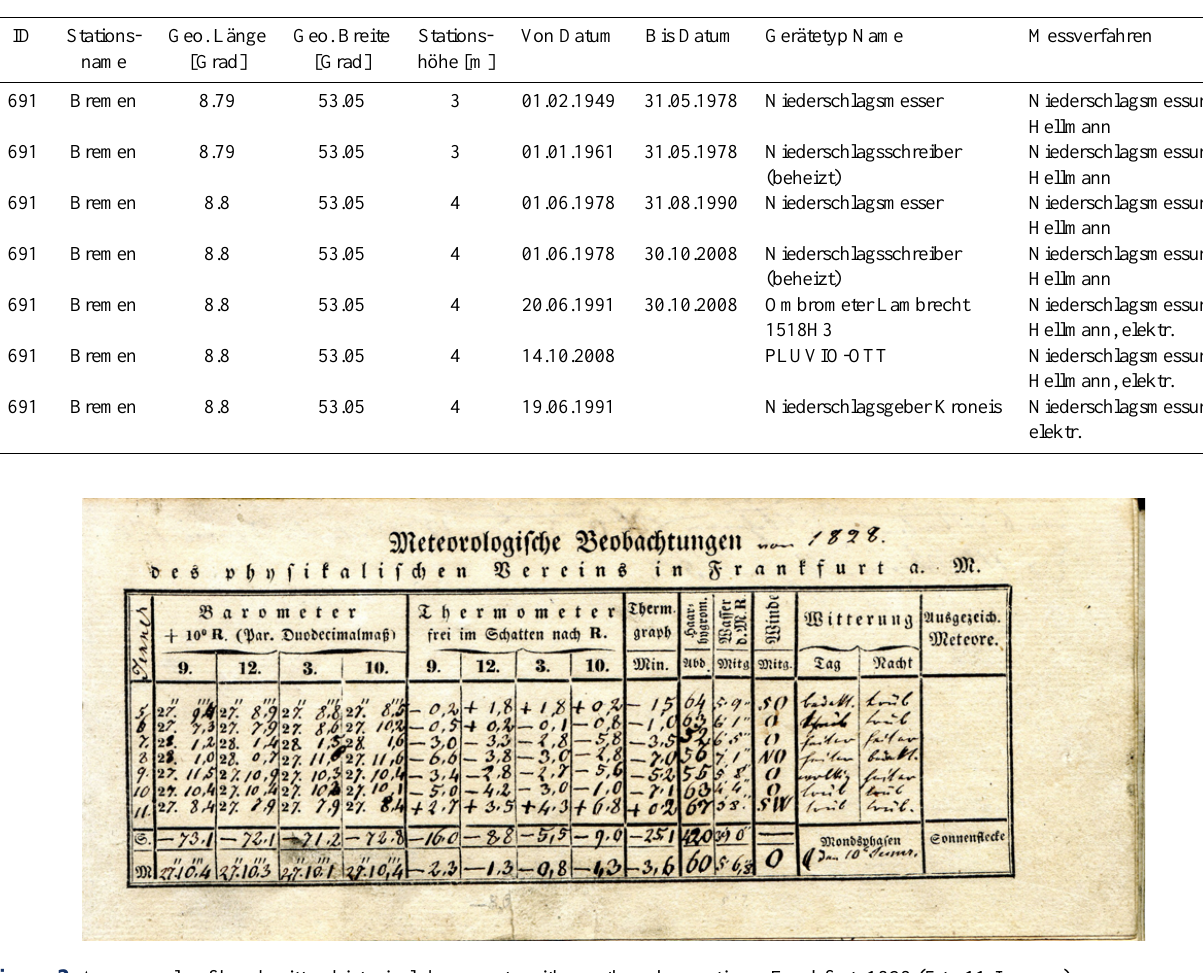
data are provided “as observed”, e.g. no homogenization pro- cedure has been applied. Information on these changes is therefore provided together with the data. A homogenization procedure has only been applied to selected parameters at monthly resolution (Herzog and Müller-Westermeier,